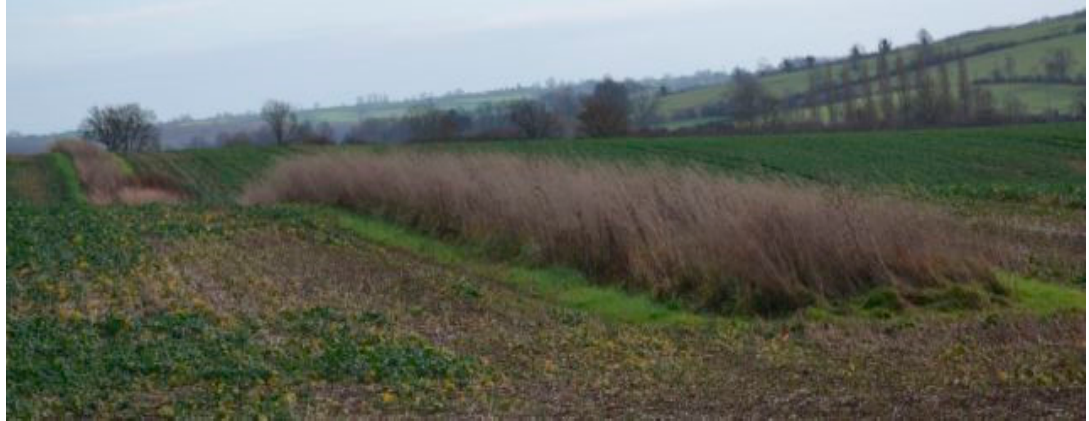
Figure 2. Beetle banks not only provide biological control of crop pests but can, when established on the contour, control surface runoff. (Photo: B Sims) . the contour, control surface runoff. (Photo: B